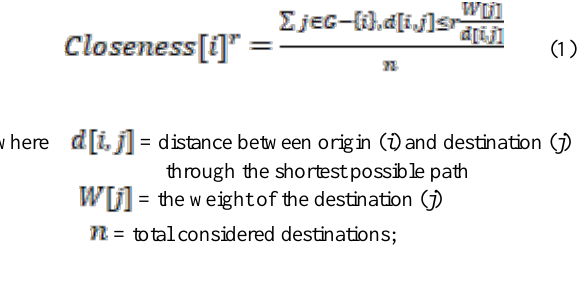
Figure 7. Pedestrian movement pattern at the T-way junction crossing area which was recorded by the pedestrian detection system and proceeded with image adjusting